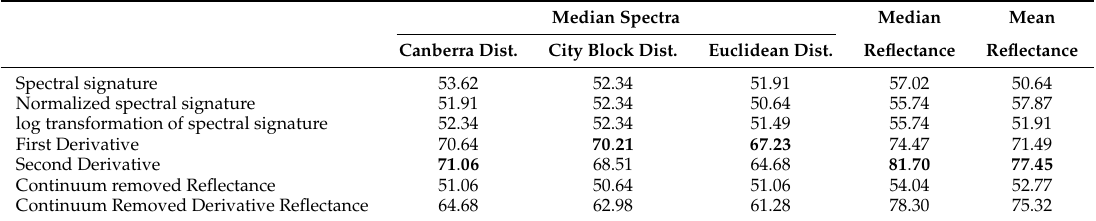
Table 7. Overall accuracy (%) for Canberra distance on [350–2500 nm].